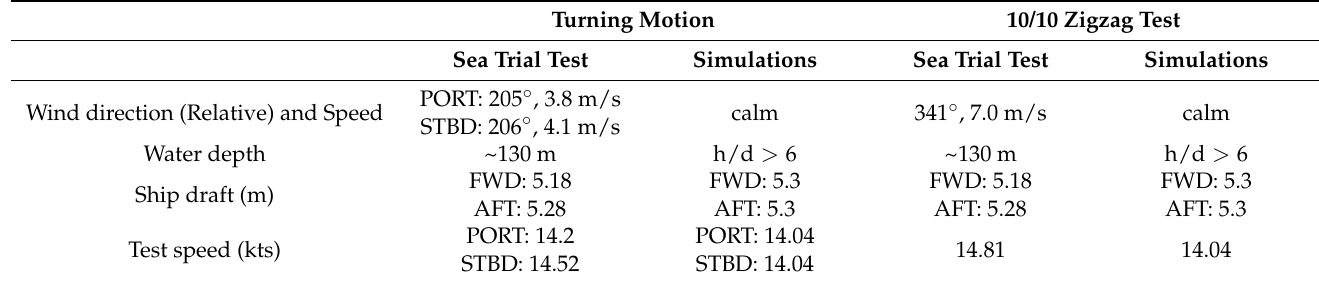
Table 6. Maneuverability evaluation conditions.